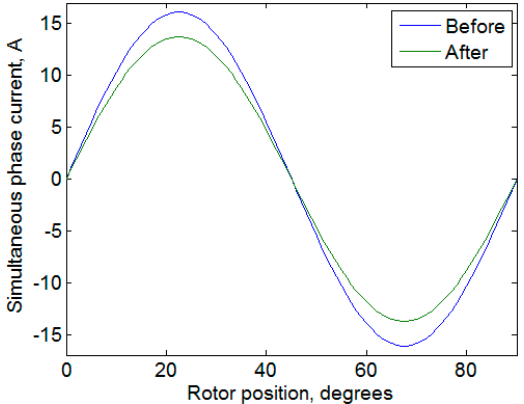
Figure 12. Comparison of phase current waveforms of the three-phase FRMs at rated torque.